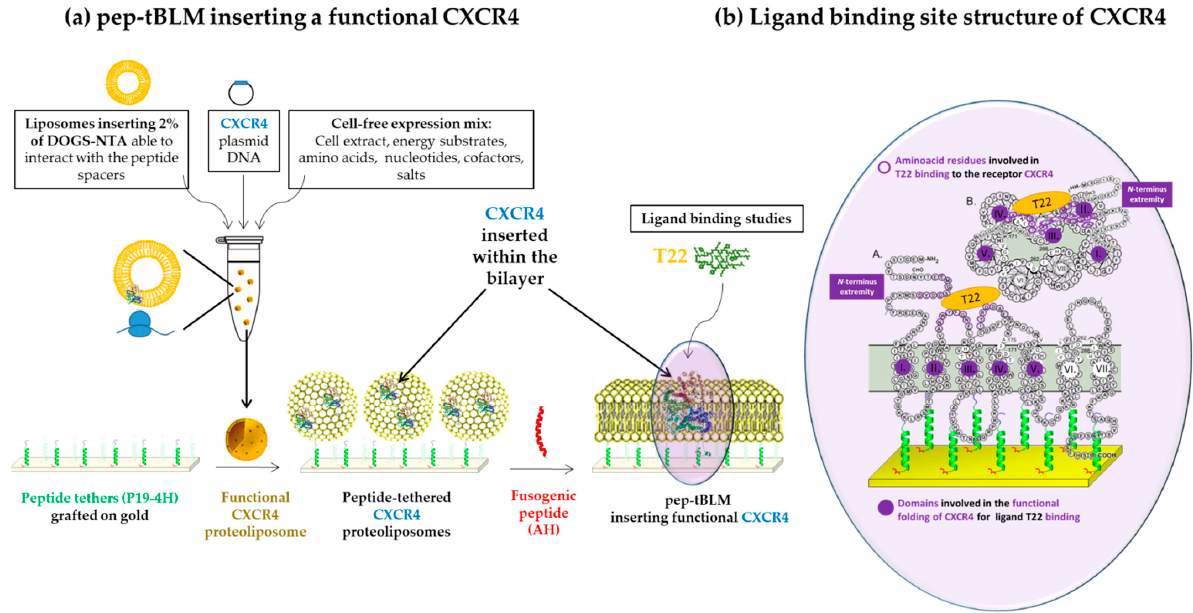
Figure 4. ( a ) pep-tBLM obtained by “top-down” approach, integrating a functional C-X-C motif chemokine receptor 4 (CXCR4), a seven-transmembrane protein belonging to the large superfamily of G-protein-coupled receptors (GPCRs) of high pharmacology interest. The functional proteoliposome has been previously obtained by a cell-free expression system in presence of pure liposomes; ( b ) side (A) and top (B) views of the binding site structure of functional CXCR4 inserted in the pep-tBLM with domains and aminoacid residues (highlighted in purple) involved in the specific binding of T22, an antagonist ligand which specifically inhibits human immunodeficiency virus type 1 (HIV-1) infection mediated by CXCR4. This structure reveals that the binding site of T22 is localized outside the membrane and that 5 domains need to be correctly folded for a functional activity. Hence, characterizing T22 binding is not only a good indicator of the functional folding of the receptor, but also gives information about the orientation of the receptor inside the membrane (adapted with permission from [200]. Copyright 2017, American Chemical Society). Table 3. Non-exhaustive lipid compositions leading to the formation of a fluid and